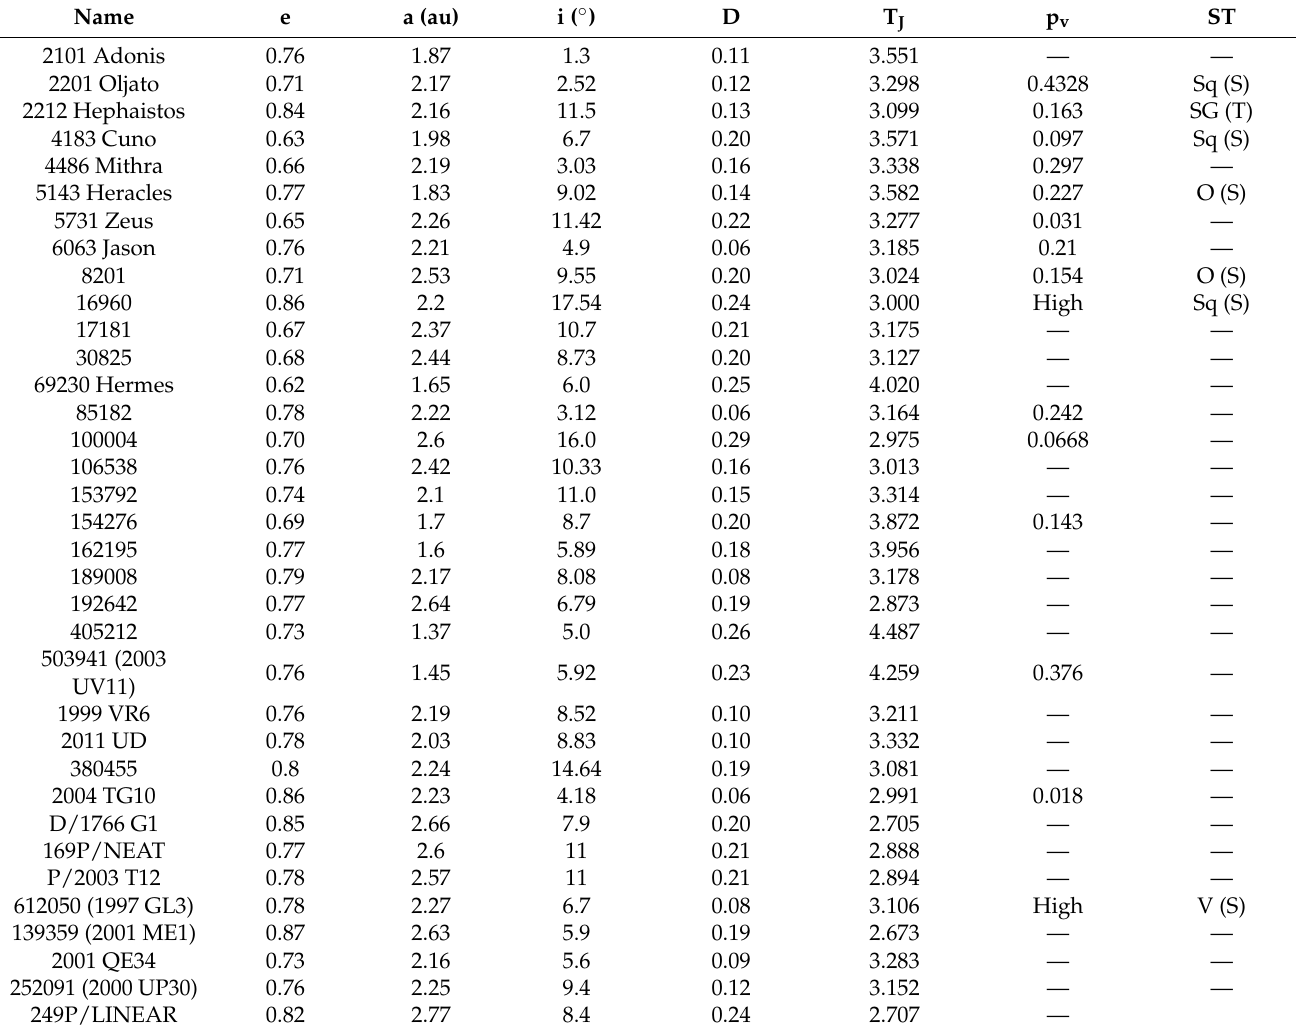
Table 2. Physical properties of the members of the Taurid Complex [27]. The table reports the name of the object as well as the eccentricity (e), the semi-major axis (a), the orbital inclination (i), the D parameter, the Tisserand parameter with respect to Jupiter (T J ), the geometric albedo (p v ), and the spectral type (ST). In this last column, (S) indicates a SMASSII spectral type [18], while (T) stands for a Tholen spectral type [19]. High albedos are expected for 16960 and 612050 due to their spectral types. Note that 2101 Oljato is in common with the list reported in Table 1. Data taken from the NASA/JPL Small-Body Database